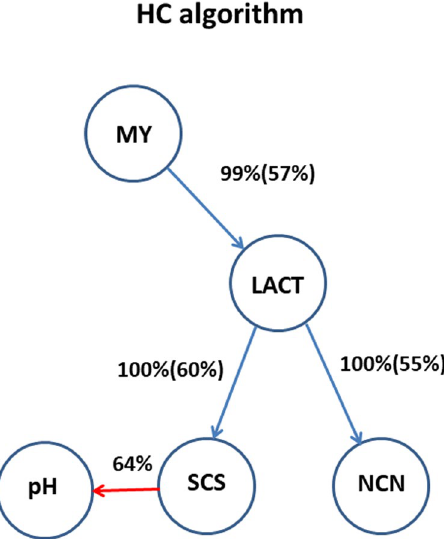
Figure 1. Network structure inferred from the vector of the residuals using the Hill-Climbing (HC) algorithm. Network structure inferred combining the results obtained with HC algorithm and prior biological knowledge (for trait pH). Structure learning test was performed with 50,000 bootstrap samples. The percentages reported beside edges indicate the proportion of bootstrap samples supporting the edge and (in parentheses) the proportion having the direction shown.